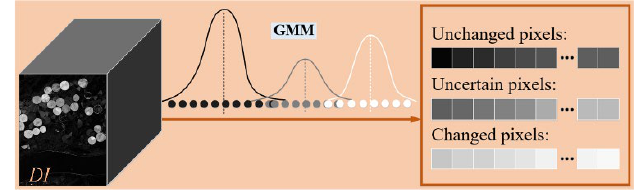
Figure 3. The schematic diagram of GMM in SSCF.